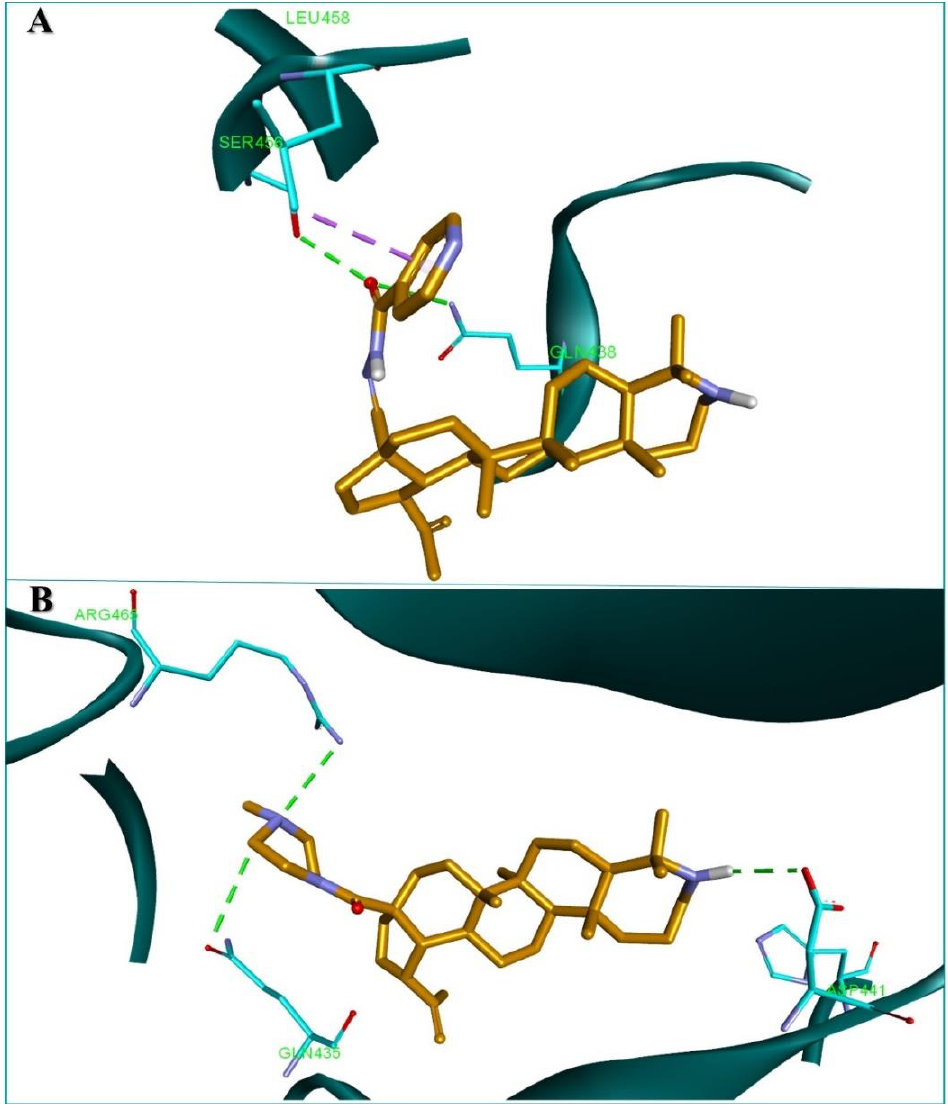
Figure 3. Structure of M. tuberculosis RNAP (5UHB) in complex with compound 7 ( A ) and compound 9 ( B ); HB interactions are depicted as green dotted lines and hydrophobic interactions as purple dotted lines; interacting amino acids are shown as light blue sticks and docked compounds are colored in orange.